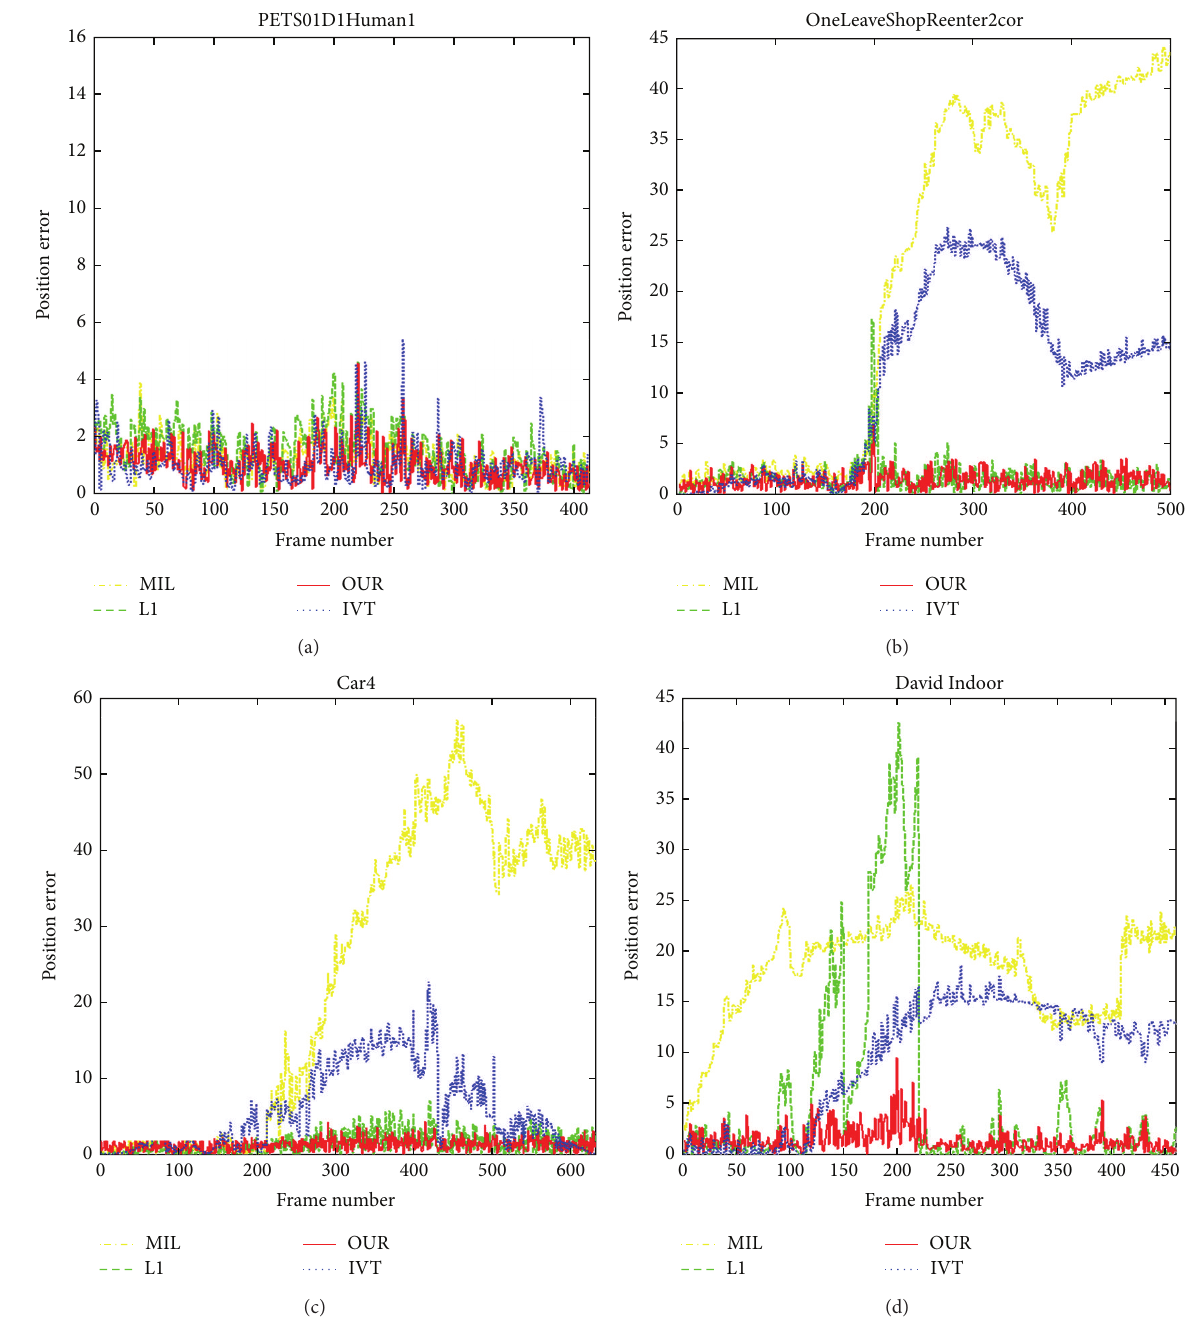
Figure 9: Position error plots of the tested